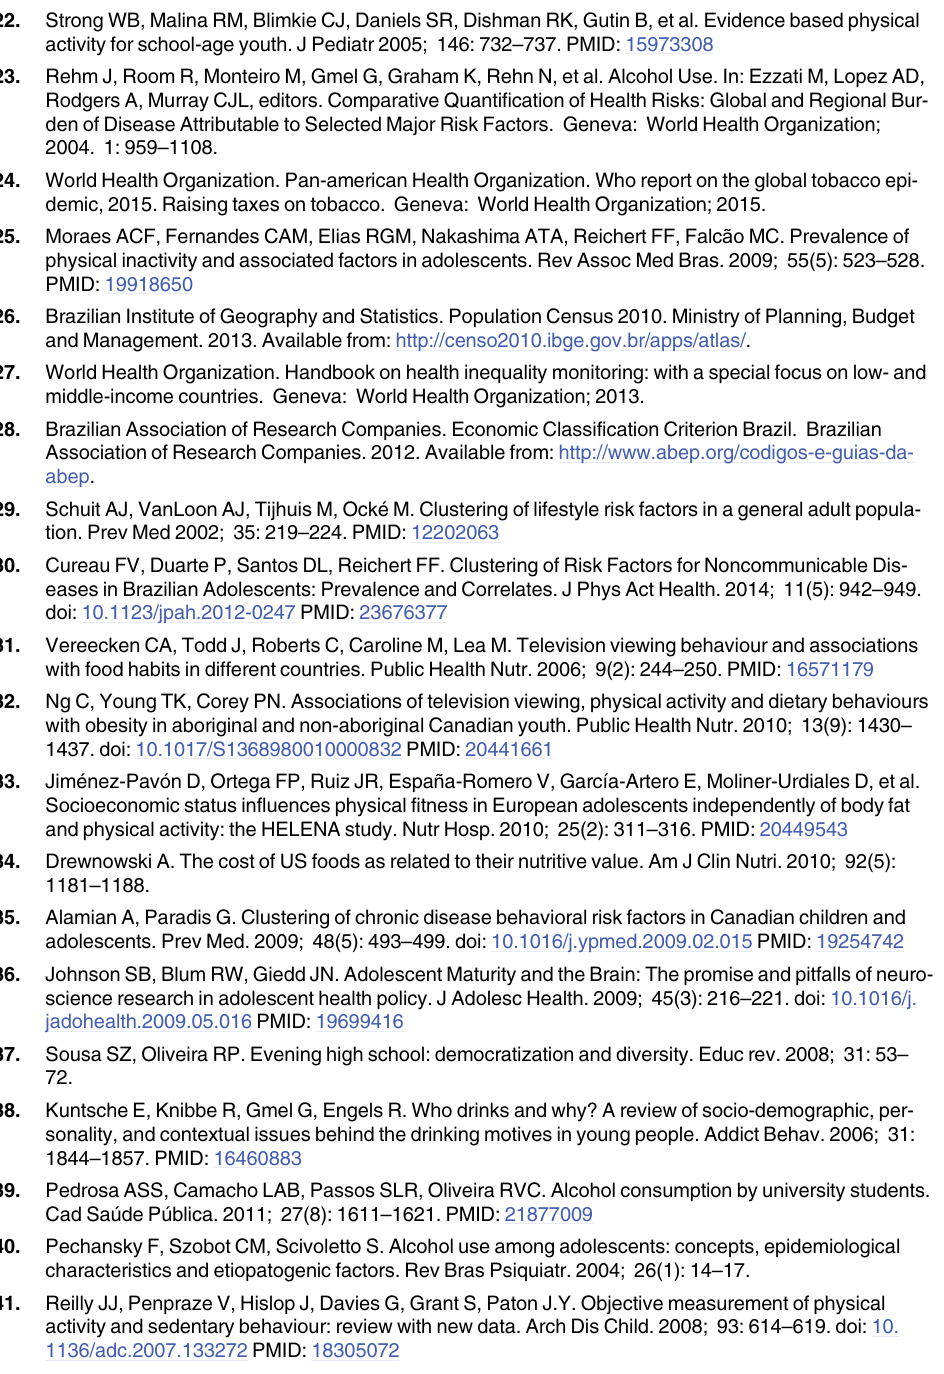
PLOS ONE | DOI:10.1371/journal.pone.0159037 July 19,